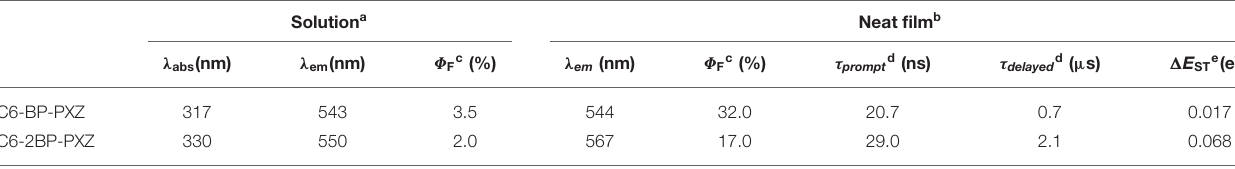
TABLE 1 | Photophysical properties of FC6-BP-PXZ and FC6-2BP-PXZ.